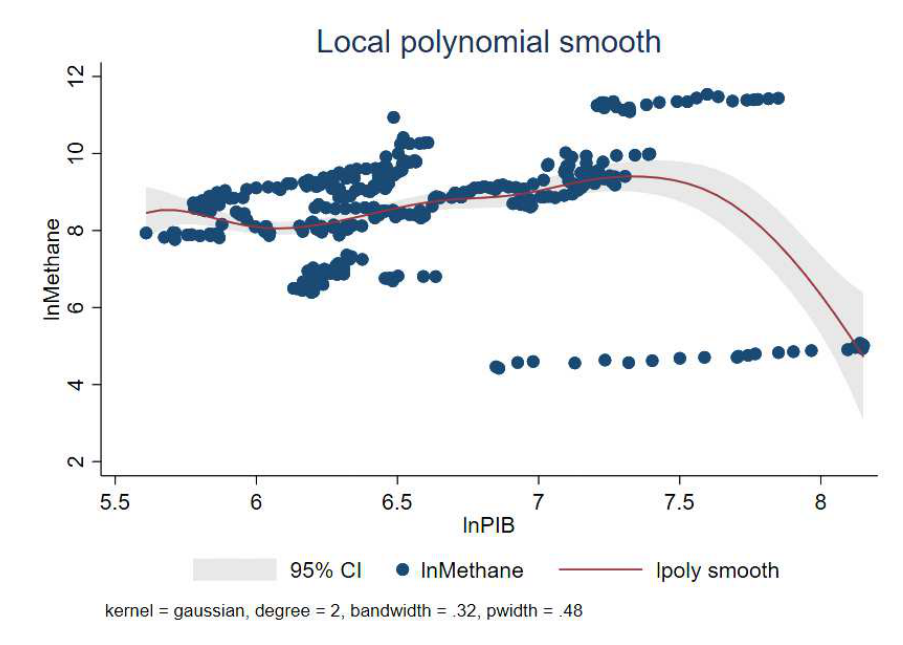
Figure 3. Partial adjustment of the income-methane emission